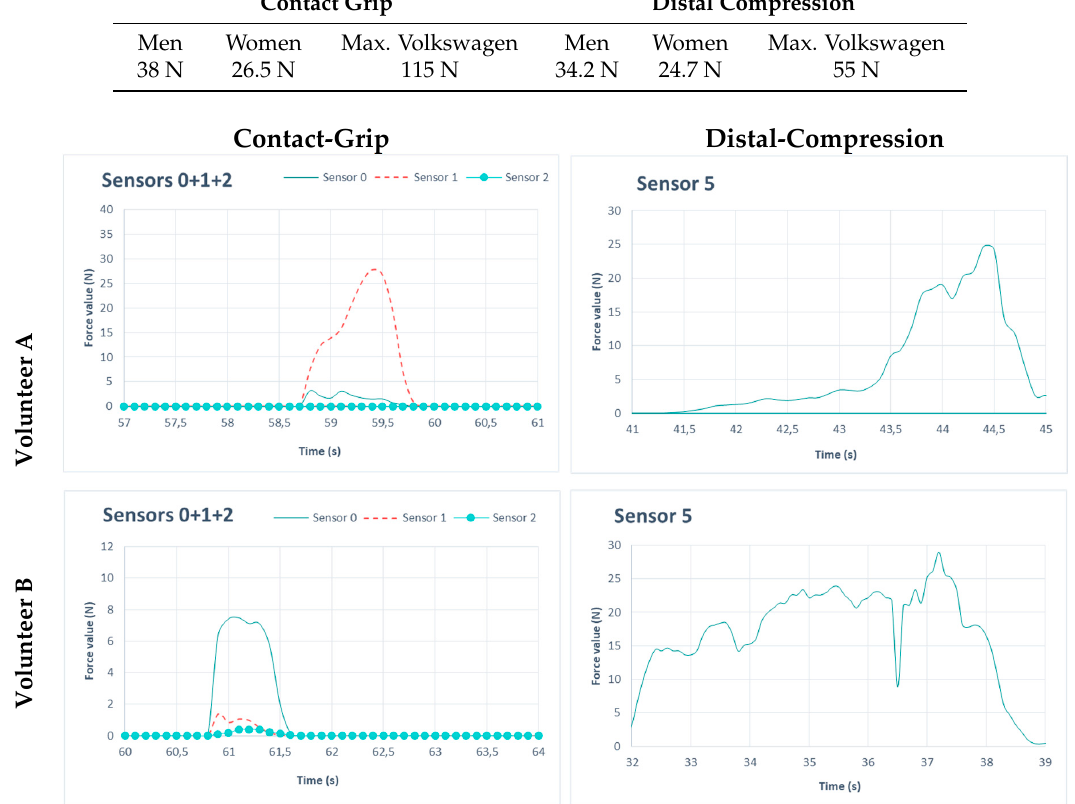
Figure 13. Sensors performance during the assembly tasks.